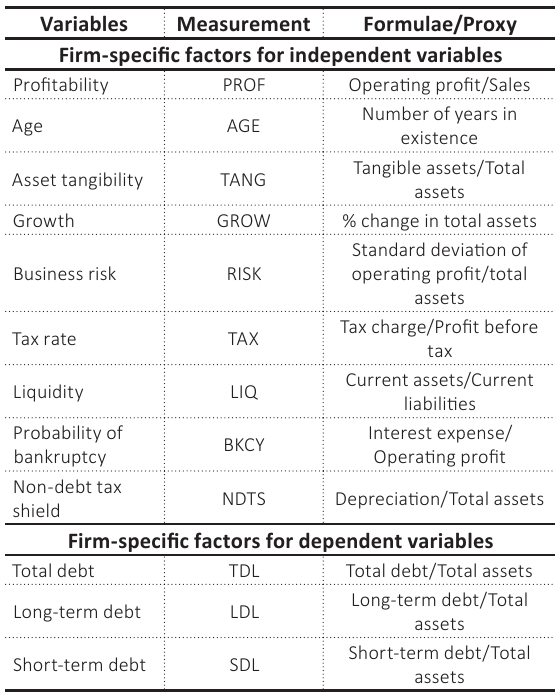
Table 1. Summary of variables and